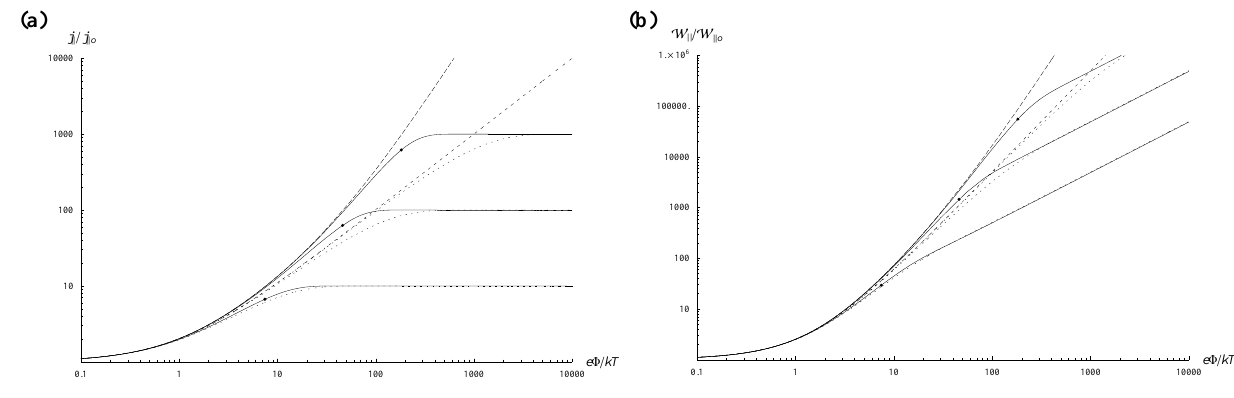
Fig. 3. Plots showing the variation of (a) the normalised field-aligned current density (cid:0) j || (cid:14) j || o (cid:1) (or number flux), and (b) the normalised field-aligned kinetic energy flux (cid:0) W || (cid:14) W || o (cid:1) of the accelerated population, plotted versus normalised acceleration potential (cid:0) e8 (cid:14) kT (cid:1) for fixed values of the magnetic field ratio (cid:0) B (cid:14) B o (cid:1) beneath the voltage drop. The fluxes are normalised to the corresponding values for the unaccelerated population in each case, given by Eq. (17). The three pairs of solid and dotted lines in each plot correspond to the relativistic values and non-relativistic approximations, respectively, for (cid:0) B (cid:14) B o (cid:1) = 10, 100, and 1000, from the bottom to the top of each plot. These curves are given by Eqs. (23) and (24) for the current density, and Eqs. (26) and (27) for the kinetic energy flux. As in previous figures, all (cid:16) . (cid:17) = 20, corresponding to kT ∼ 25keV for electrons. Relativistic mc 2 kT curves are for a non-relativistic unaccelerated population satisfying (cid:16) . (cid:17) ≥ 1 thus correspond to (cid:0) e8 (cid:14) kT (cid:1) ≥ 20. The long- and medium-dashed lines correspond to the relativistic e8 mc 2 accelerations satisfying value and the non-relativistic approximation, respectively, of the limiting fluxes for (cid:0) B (cid:14) B o (cid:1) → ∞ (limit “B”), given by Eqs. (33) and (35a) for the current density, and Eqs. (34) and (35b) for the kinetic energy flux. The solution curves in each case follow this limiting behaviour for sufficiently small (cid:0) e8 (cid:14) kT (cid:1) , before asymptoting to the opposite limit (limit “A”) given by Eqs. (28) and (29) at sufficiently large (cid:0) e8 (cid:14) kT (cid:1) . The transition between these two limiting regimes on each solid curve is shown by the solid dot, whose position is determined by the condition given by Eq. (36), specifically by Eq.